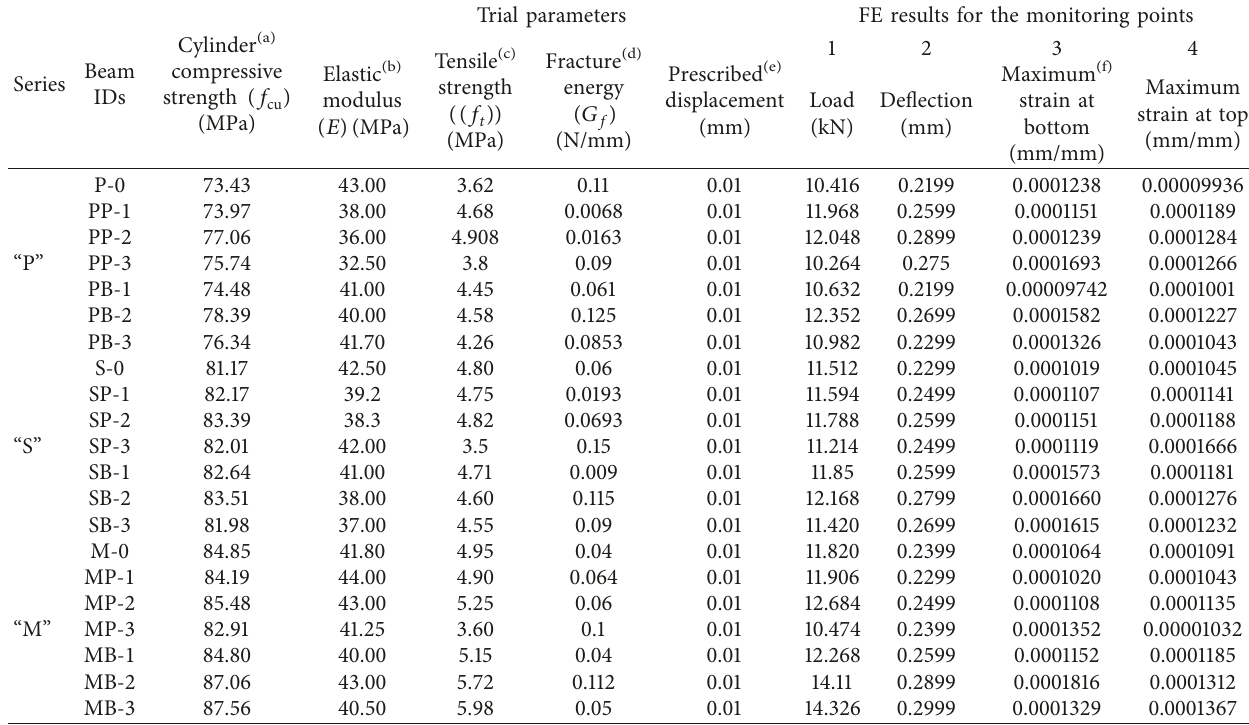
Table 6: Summary of the initial material input parameters, FEA parameters, and